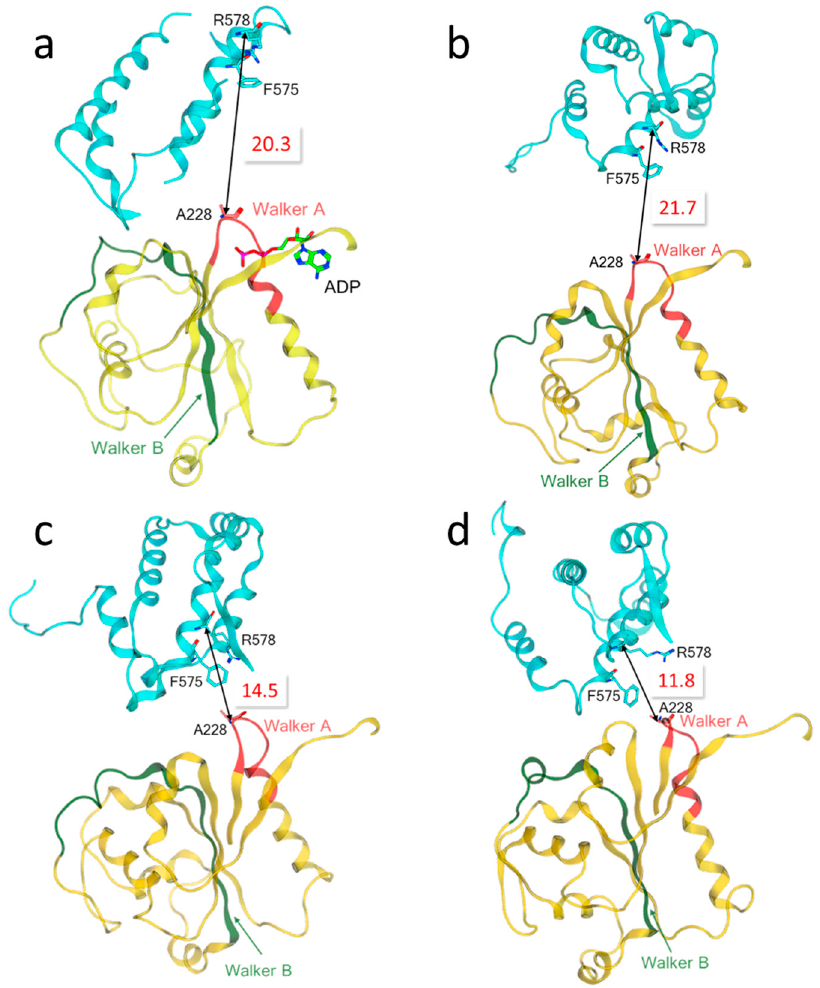
Figure 2. Relative positions between two key residues R578 and A228 of the MCC950 binding pocket in ( a ) the NLRP3-NEK7 complex structure (PDB code: 6NPY), ( b ) model 1 generated by AlphaFold, ( c ) model 4 by AlphaFold and ( d ) model 1 by RoseTTAFold. The distance between the α -carbon atoms of R578 and A228 was 20.3 Å, 21.7 Å, 14.5 Å and 11.8 Å in ( a – d ), respectively. Red: the Walker A motif (GAAGIGKTIL); Green: the Walker B motif (RILFMDGFDELQGAFDEHI) [19]; Gold: NBD; Cyan: HD2. Other domains were omitted for